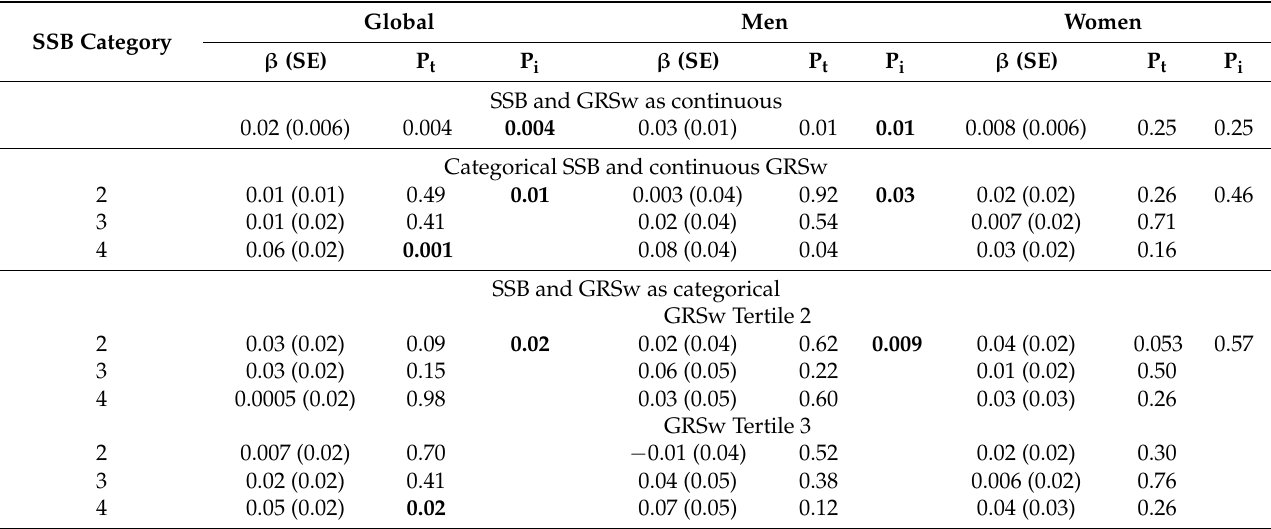
Table 4. Interaction effects between GRSw and sugar-sweetened beverages intake on fasting blood glucose levels as continuous/categorical